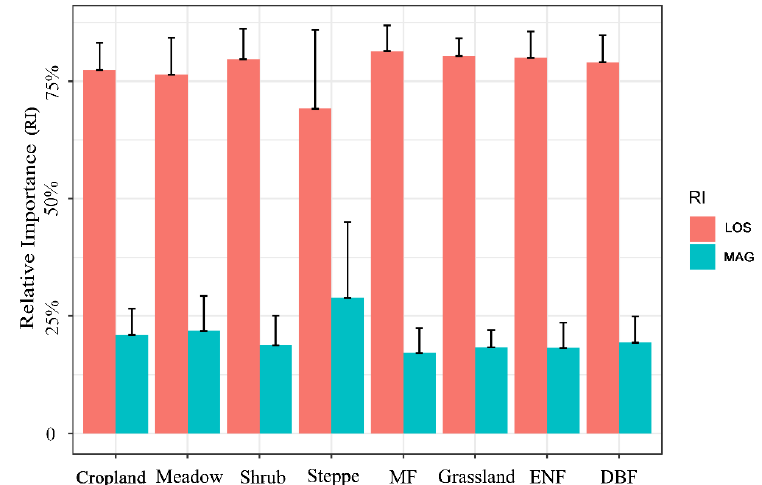
Figure 8. Relative importance (RI) of LOS and MAG to trends of vegetation productivity in different vegetation types. Bar height is the mean value for each vegetation type; the error bar denotes one standard deviation. ENF: evergreen needle-leaved forest. DBF: Deciduous broad-leaved forest. MF: mixed forest.